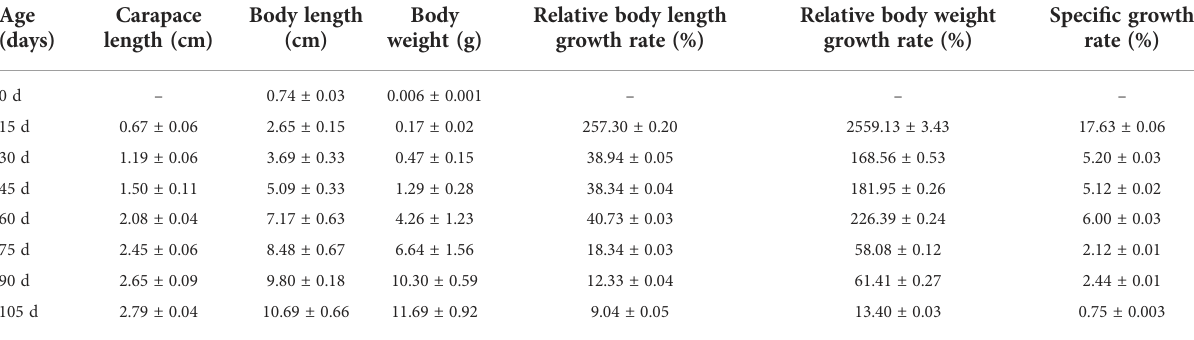
TABLE 1 Periodic growth performance of P. monodon cultured with “ Fishery-PV Integration ” engineering for 105 days. Age (days)